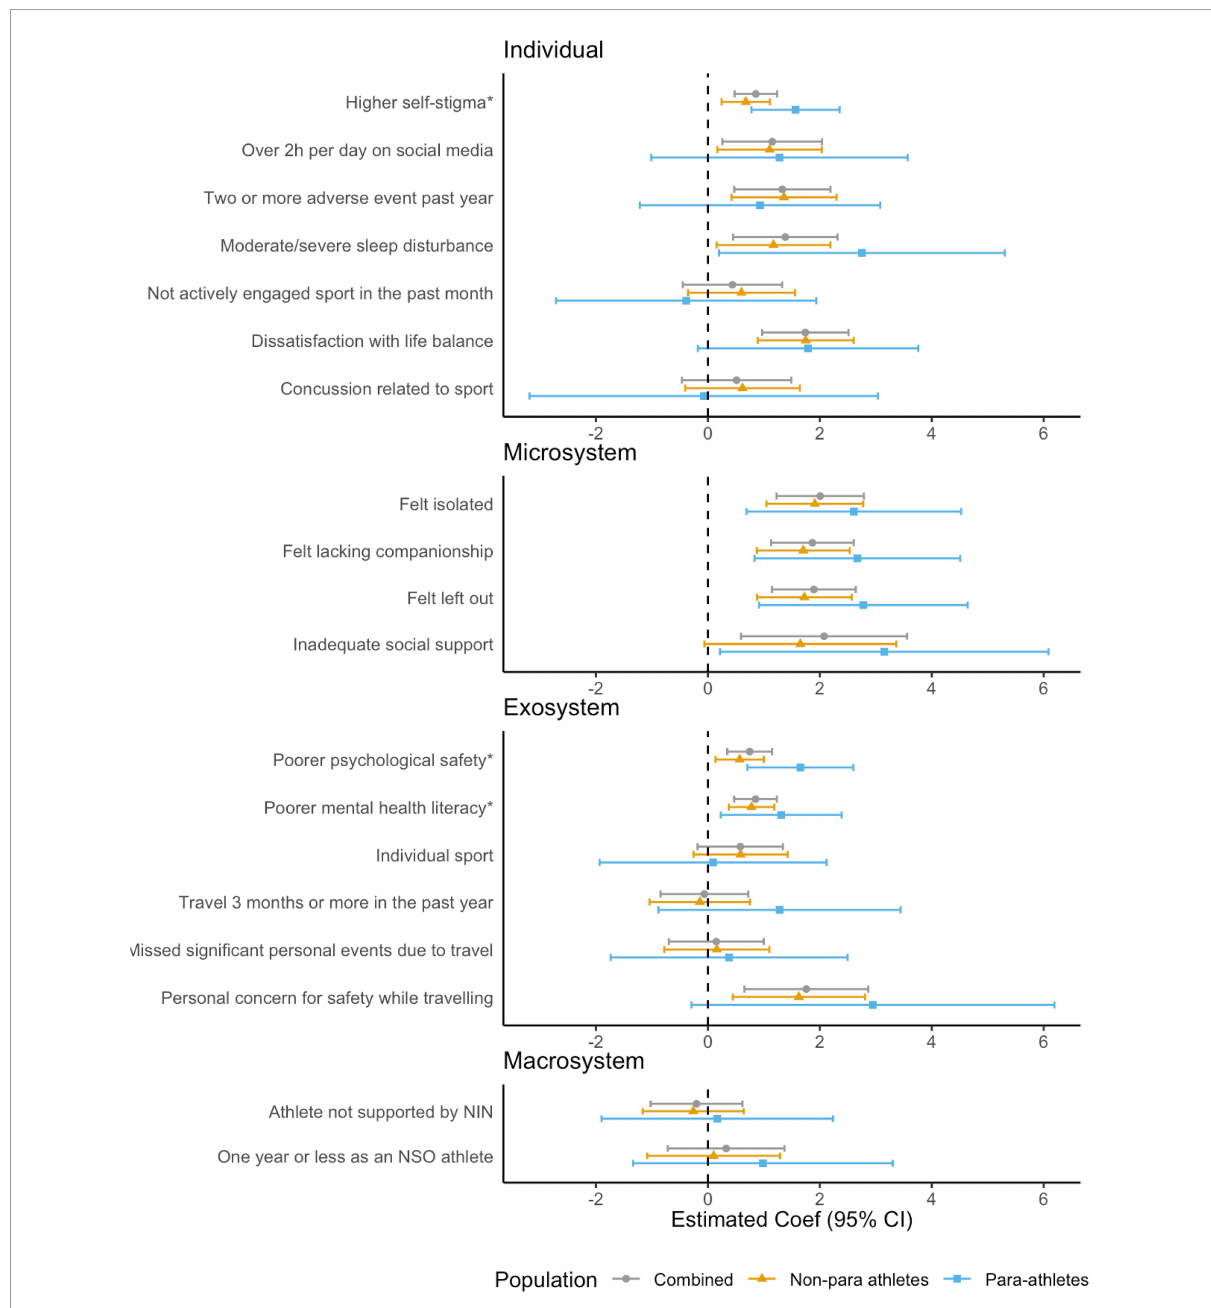
FIGURE4 Associations between risk factors and eating disorder risk (BEDA-Q) for combined, non-para and para athletes, adjusted for age and gender. *Effects associated with one standard deviation ( SD ) change in Psychological Safety subscales (Low Self-Stigma, Mentally Healthy Environment, and Mental Health